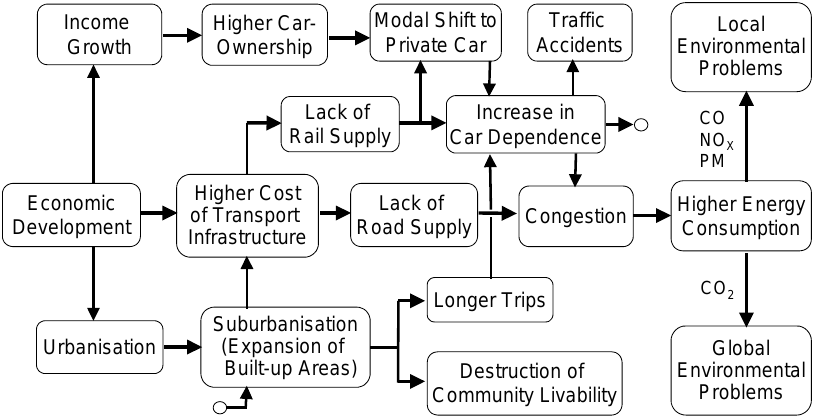
Figure 3. Causalities of deterioration in transport-related